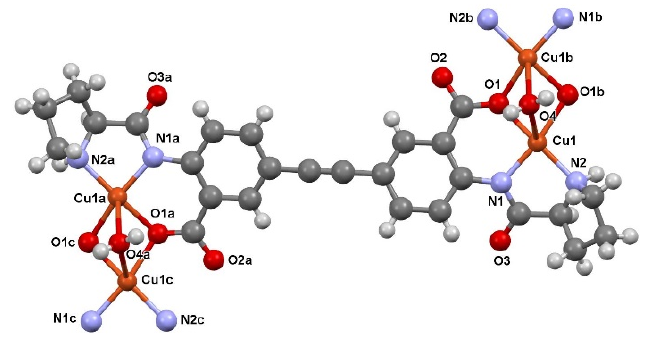
Figure 2. A portion of the crystal structure of [ Cu 2 (EDPB)•H 2 O] n , showing the atomic numbering